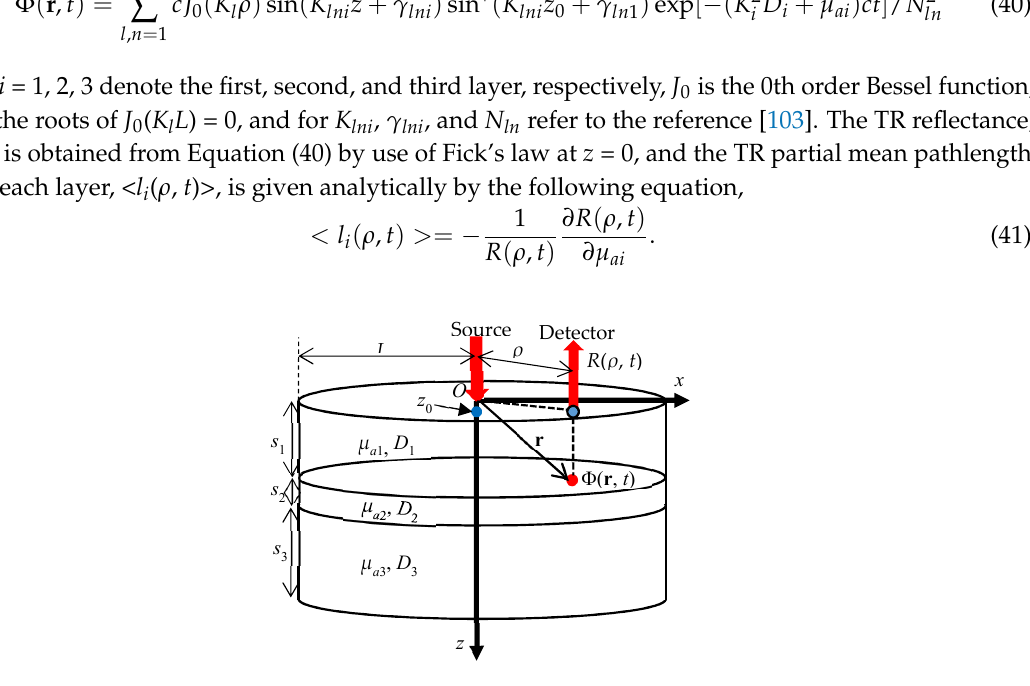
Figure 14. Geometry of a three-layered finite cylinder simulating the human head. Modified from Reference [103].